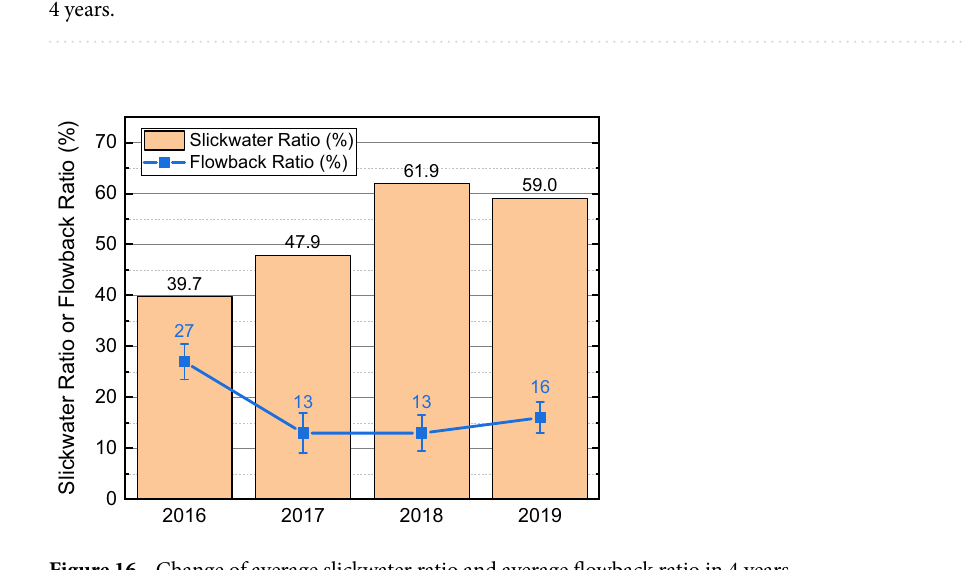
Figure 16. Change of average slickwater ratio and average flowback ratio in 4